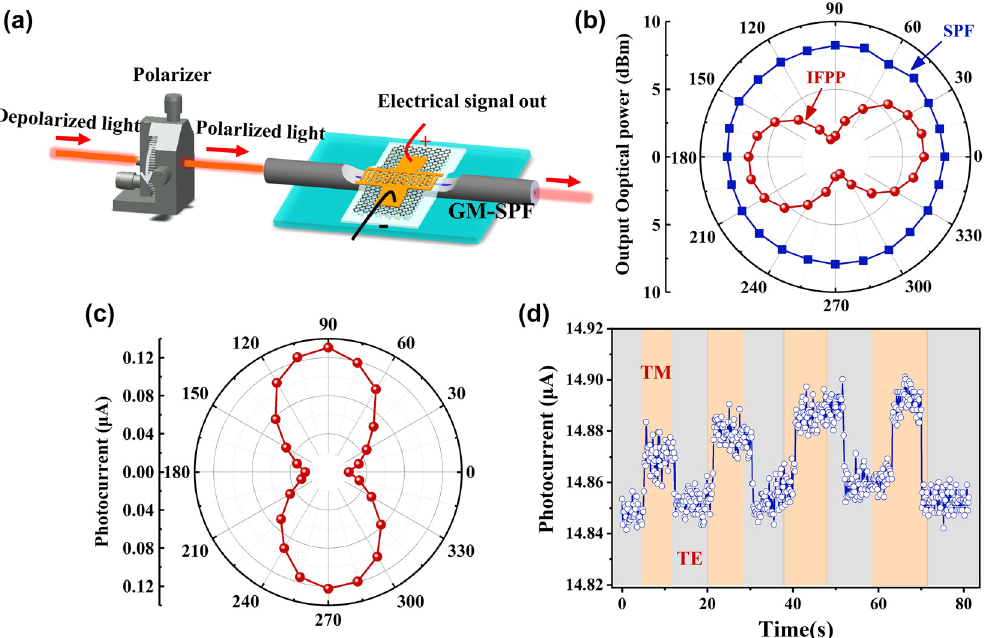
Figure 5: The polarized light detection characteristics of PPID. (a) Schematic diagram of experimental measurement of the polarization sensitivity of the PPID; (b) the output optical power through the PPID (blue squares) and the bare SPF with the different IPA in polar coordinates (red spheres); (c) polarization-dependent property of the photocurrent by the PPID at 1550 nm; (d) the PPID photocurrent when switching repeatedly between TM and TE